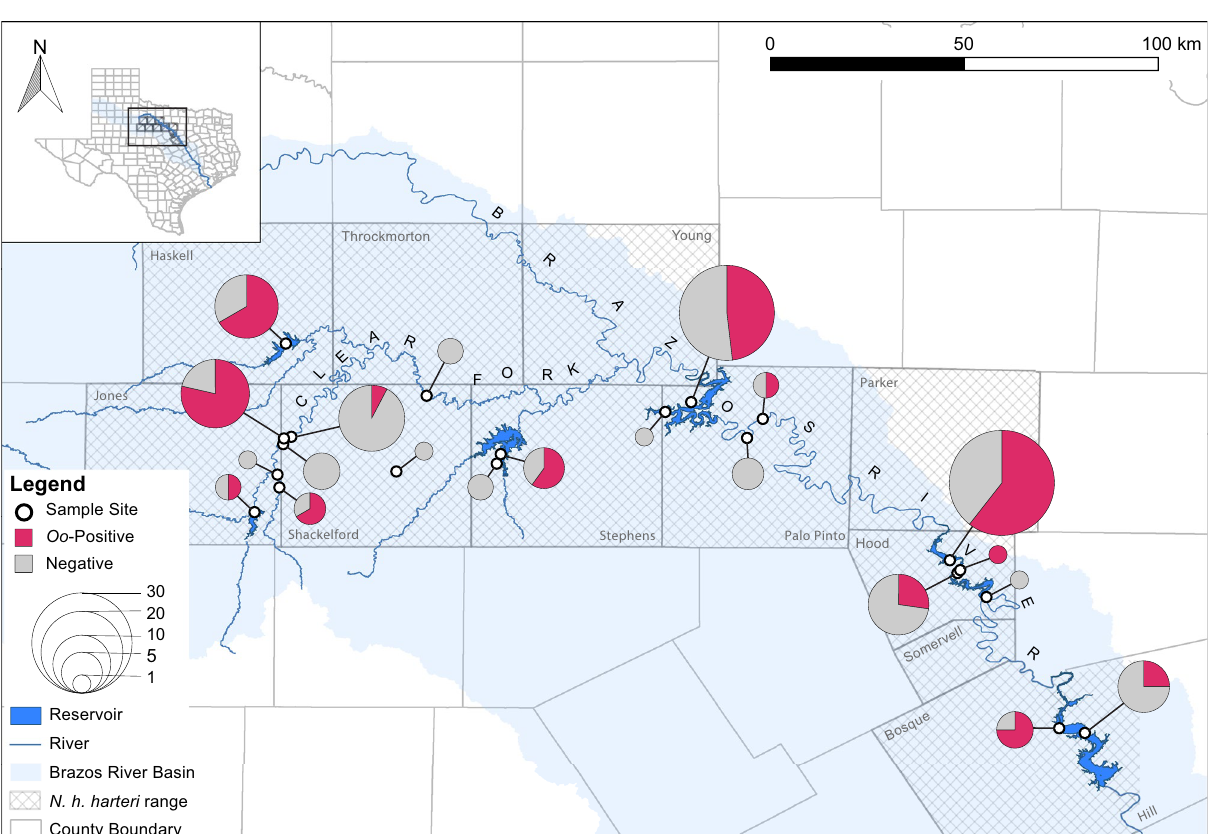
Figure 4. Map of sampling sites demarcated with open circles. Cross-hatching indicates the historical range of Nerodia harteri harteri at the county level within the Brazos River drainage designated by the shaded area . Each pie chart represents the relative proportion of Nerodia that tested positive or negative for Ophidiomyces ophiodiicola via qPCR. The size of the pie chart represents the relative number of snakes collected per site. QGIS version 3.16.3 (https:// www. qgis. org/ en/ site/) was used to generate the